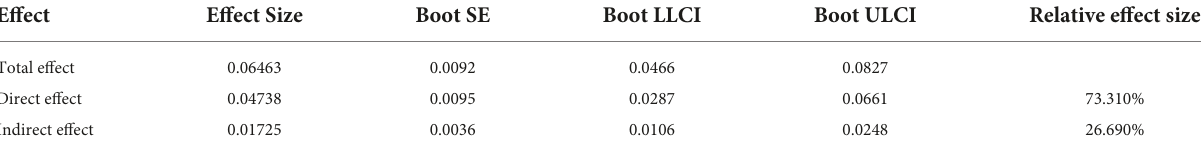
TABLE 4 Total effect, direct effect, and indirect effect among the